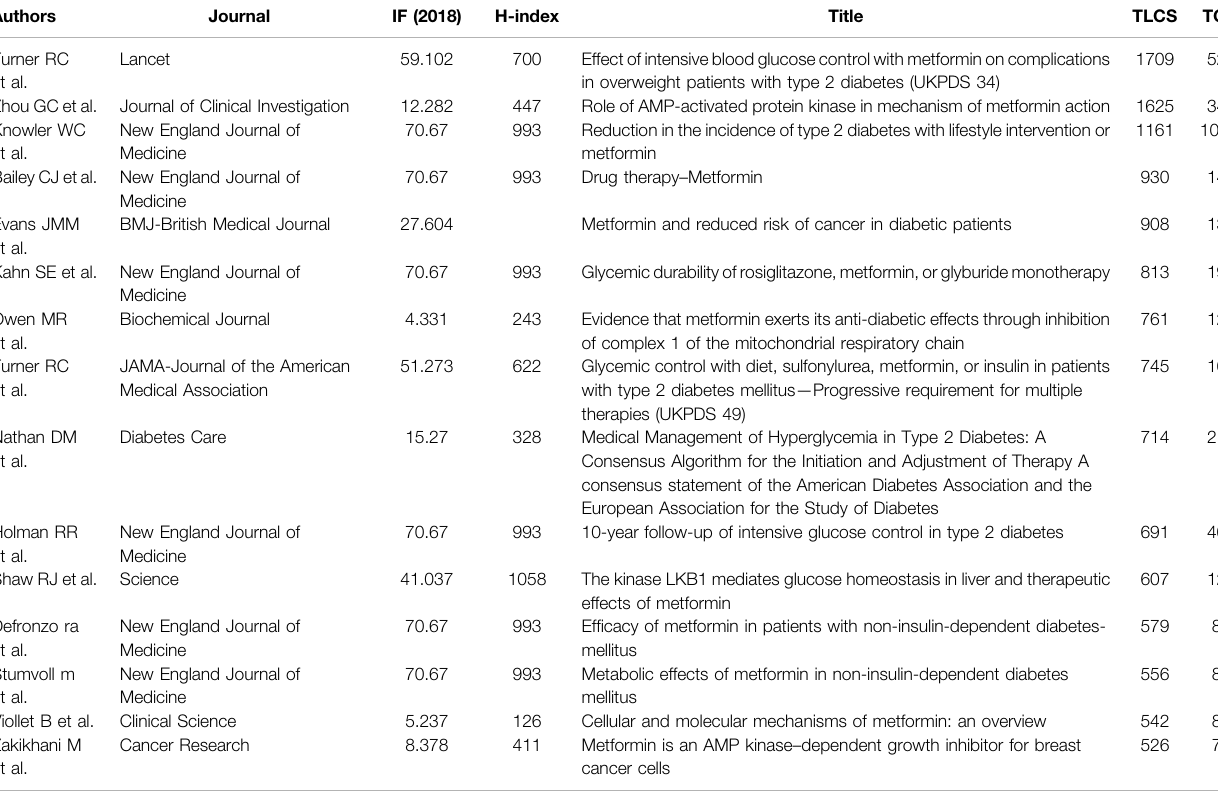
TABLE 6 | The top 15 most cited articles.